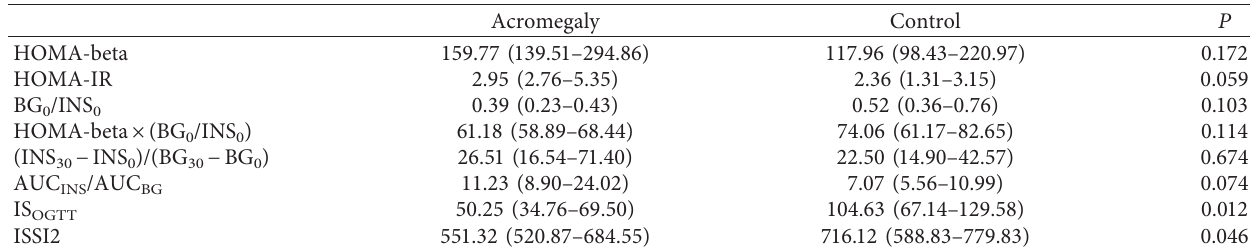
Figure 2: Glucose and insulin levels during OGTT. ∗ P < 0.05, compared with the control group and ∗∗ P < 0.01, compared with the control group. Table 2: The insulin sensitivity and beta-cell function of newly diagnosed acromegalic